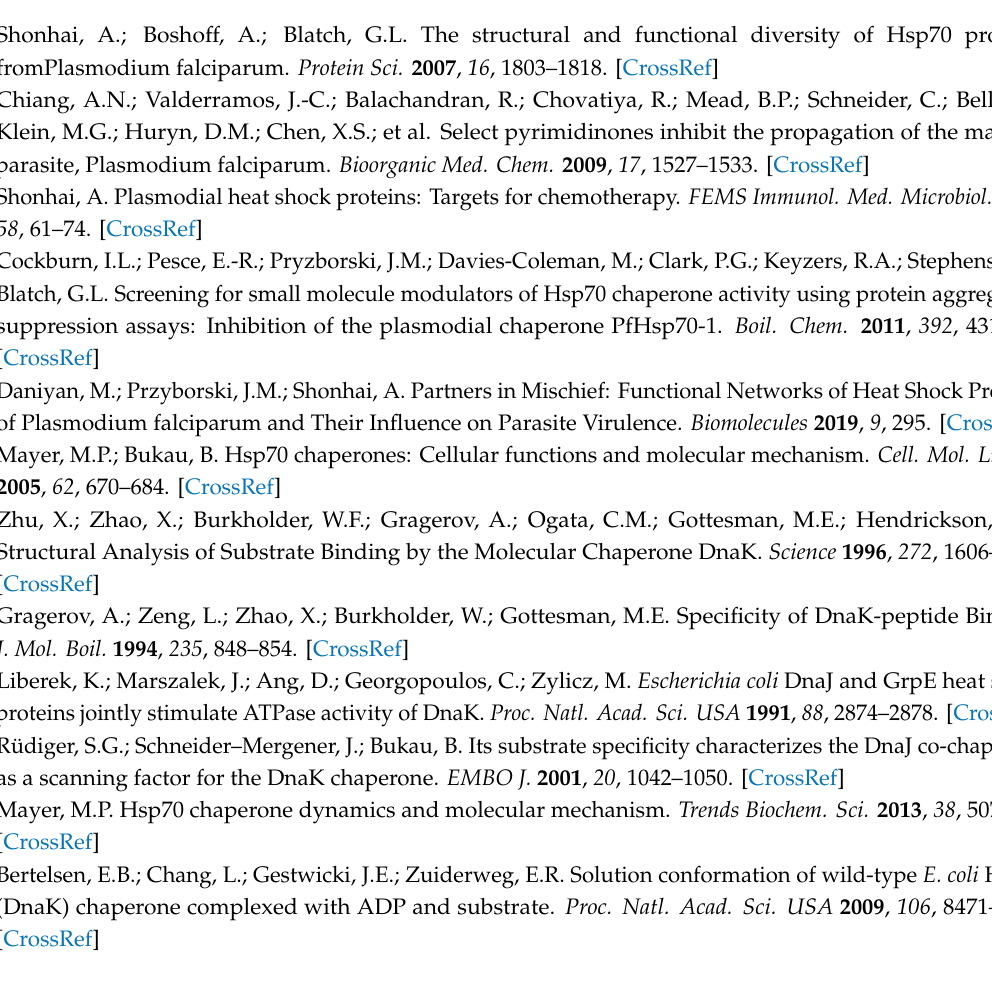
Figure S1. Homology models of the Hsp70s. Figure S2. Expression and purification of recombinant Hsp70s. Figure S3. The relative a ffi nities of DnaK, KPf and PfHsp70-1 for the various peptides were determined in the presence or absence of 5 mM ATP / ADP. Figure S4: Co-expression and purification of PfAdoMetDC. Figure S5. Combined tryptophan and tyrosine florescence spectra of PfAdoMetDC. Table S1. ATPase kinetics of